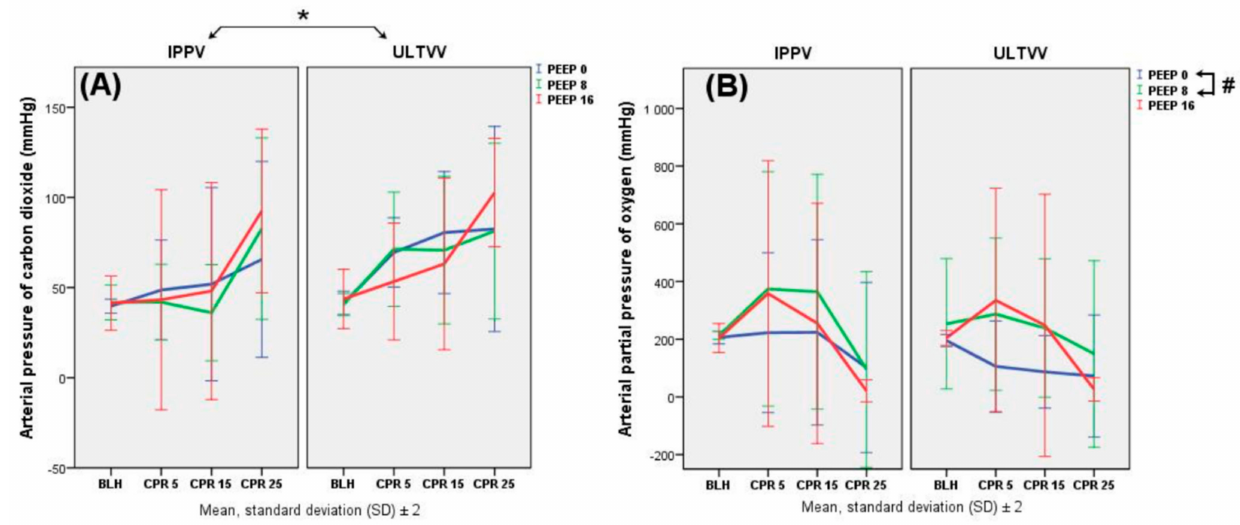
Figure 2. Blood gases: arterial partial pressure of CO 2 (PaCO 2 , ( A )), arterial partial pressure of O 2 (PaO 2 , ( B )). The unit of PaCO 2 and PaO 2 is mmHg. Data are shown as mean values and standard deviation (SD). Significant differences in paCO 2 ( A ): * ULTVV vs. IPPV, when adjusted for PEEP, p = 0.001 (RMA). Significant differences in paO 2 ( B ): # PEEP 0 mbar vs. PEEP 8 mbar, when adjusted for ventilation mode, p = 0.025 (Tukey).